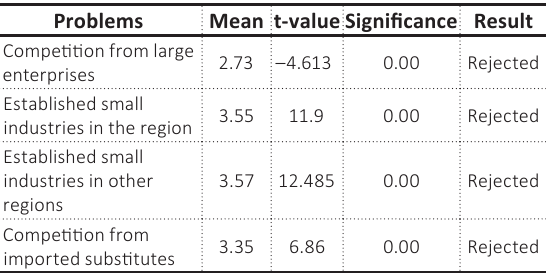
Table 10. Competition challenges